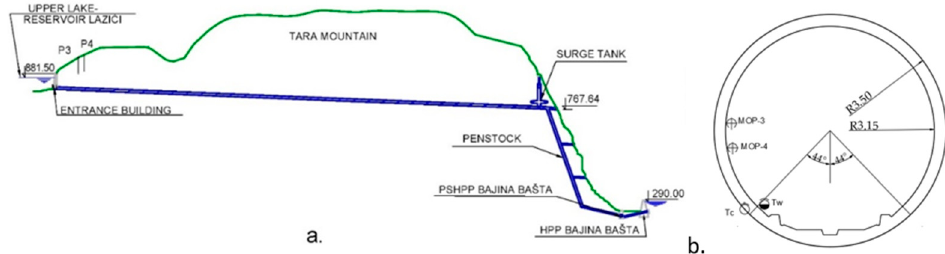
Figure 3. Longitudinal tunnel profile with a schematic view of the upper lake, pipeline, PSHPP, and HPP “Bajina Bašta” ( a ) and cross-section of tunnel ( b ).